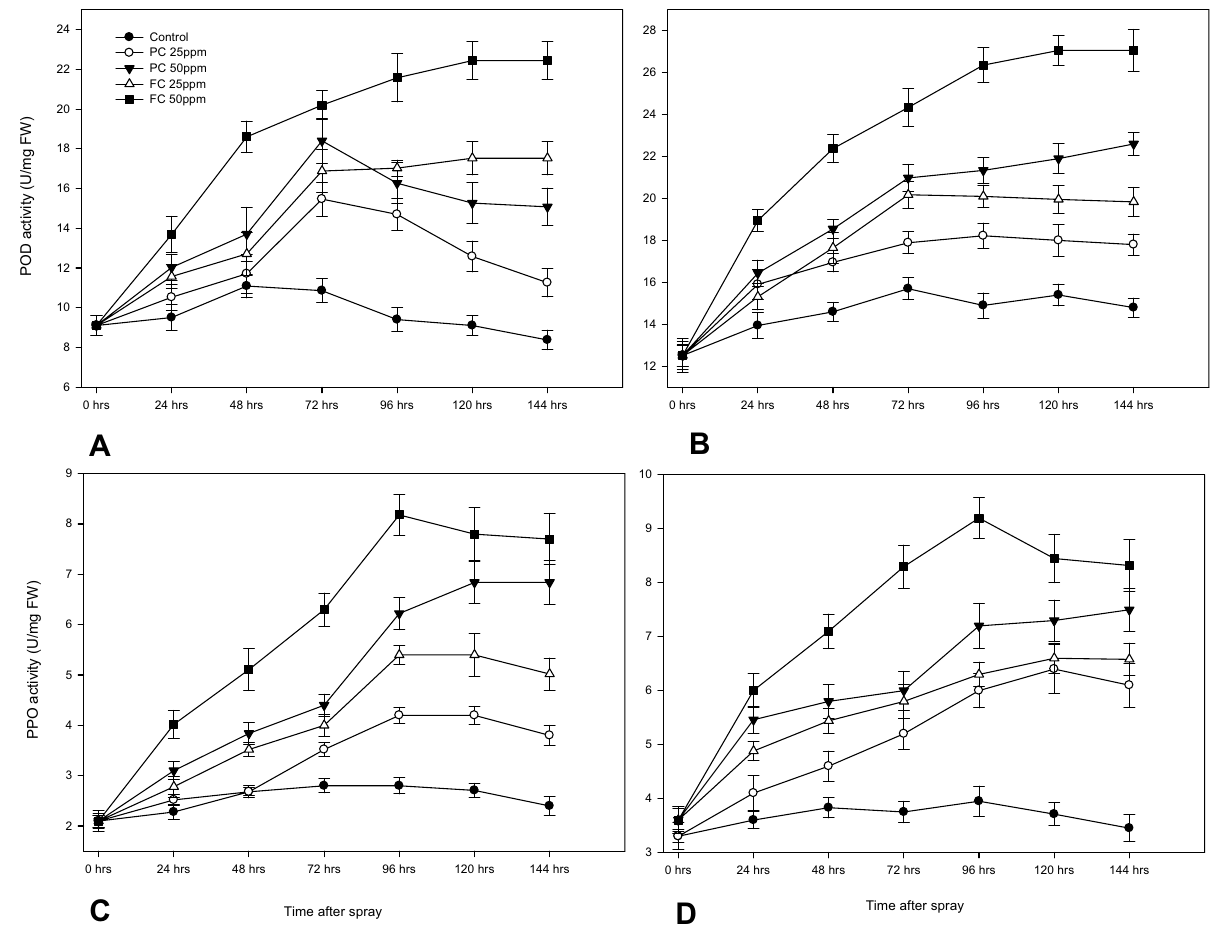
Figure 9. Effects of fungal (FC) and product chitosan (PC) treatments on POD activity in rice plants ( A —TN1, B —PTB33) and on PPO activity in rice plants ( C —TN1, D —PTB33). Data represent the means of five replicates of each